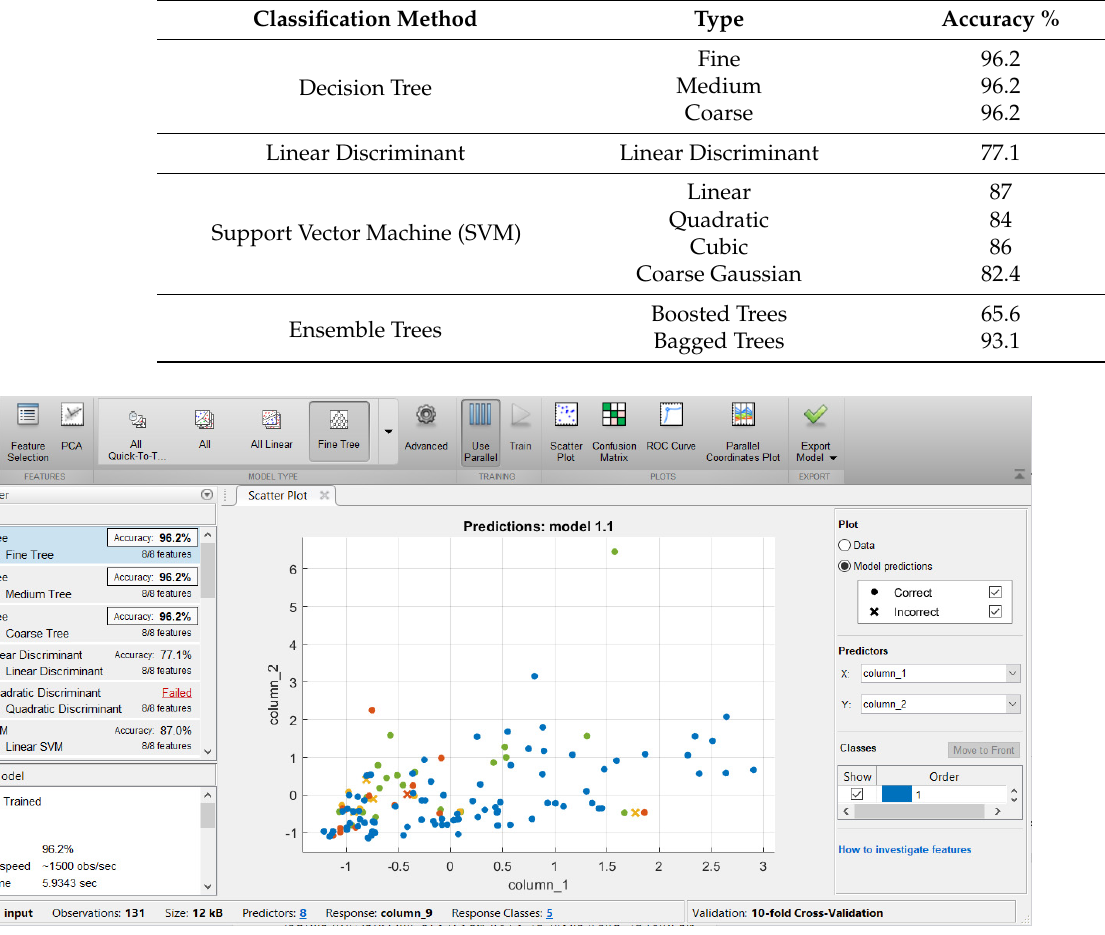
Figure 6. Screens shoot of the scatter plot of classification accuracy of the decision tree classifier. Table 4. Accuracy of the classification techniques on the collected test data. Classification Method